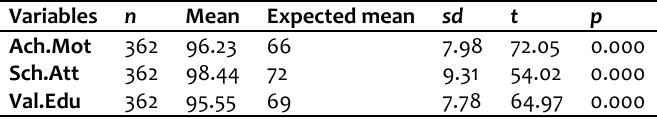
Table ‐ 3: Results of one ‐ sample t ‐ test analysis